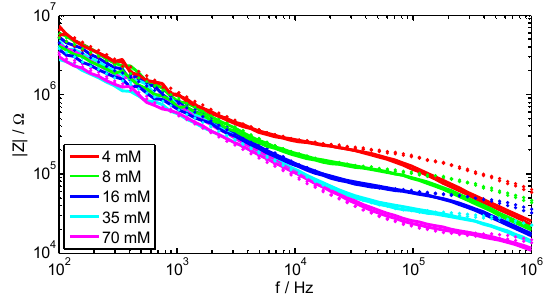
Fig.12: Magnitude of the impedance measured with multiplexed frontend (dots) and by direct attachment of the chip to the